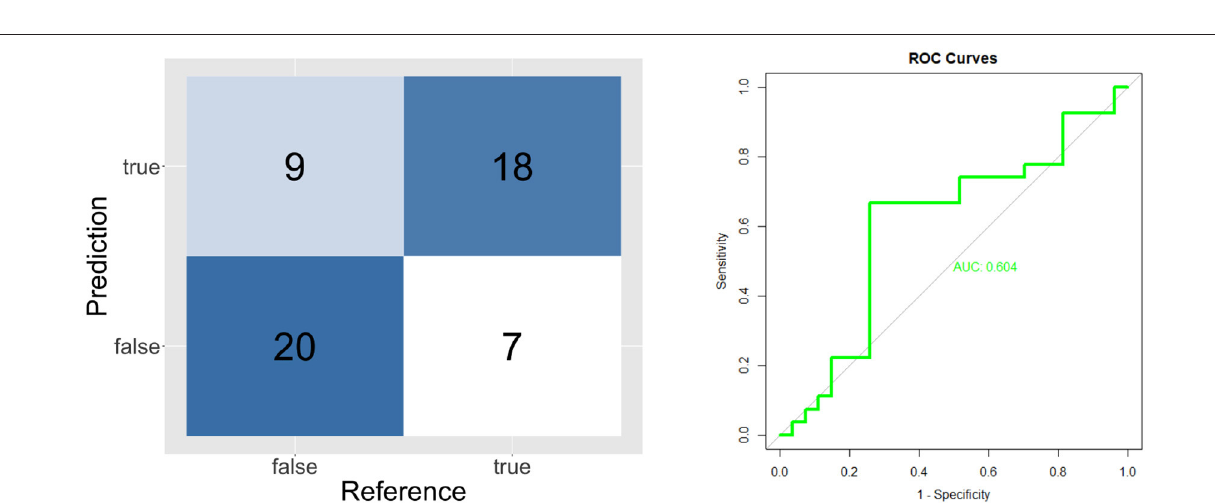
Frontiers in Human Neuroscience |